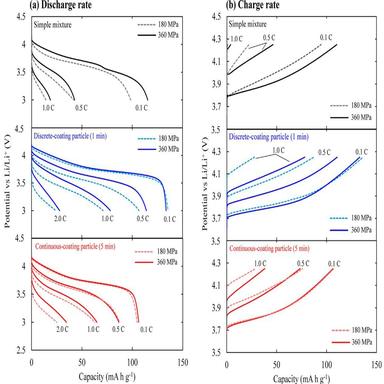
(a) Discharge and (b) charge curves of all-solid-state half-cells prepared from the simple mixture, discrete-coating particle (1 min), and continuous-coating particle (5 min) with different press pressure at 298 K.